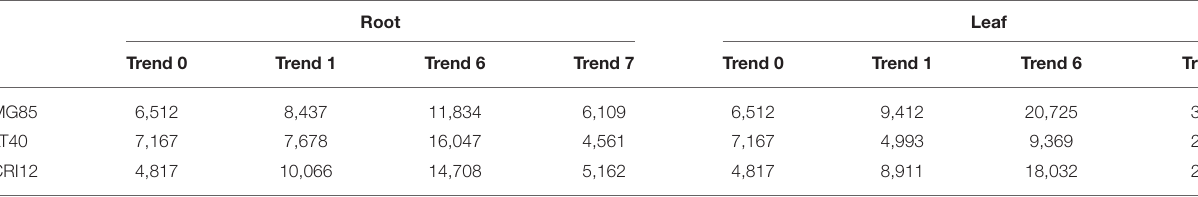
TABLE 2 | Trends of DEGs expressions levels in MG85, LT40, and CRI12.